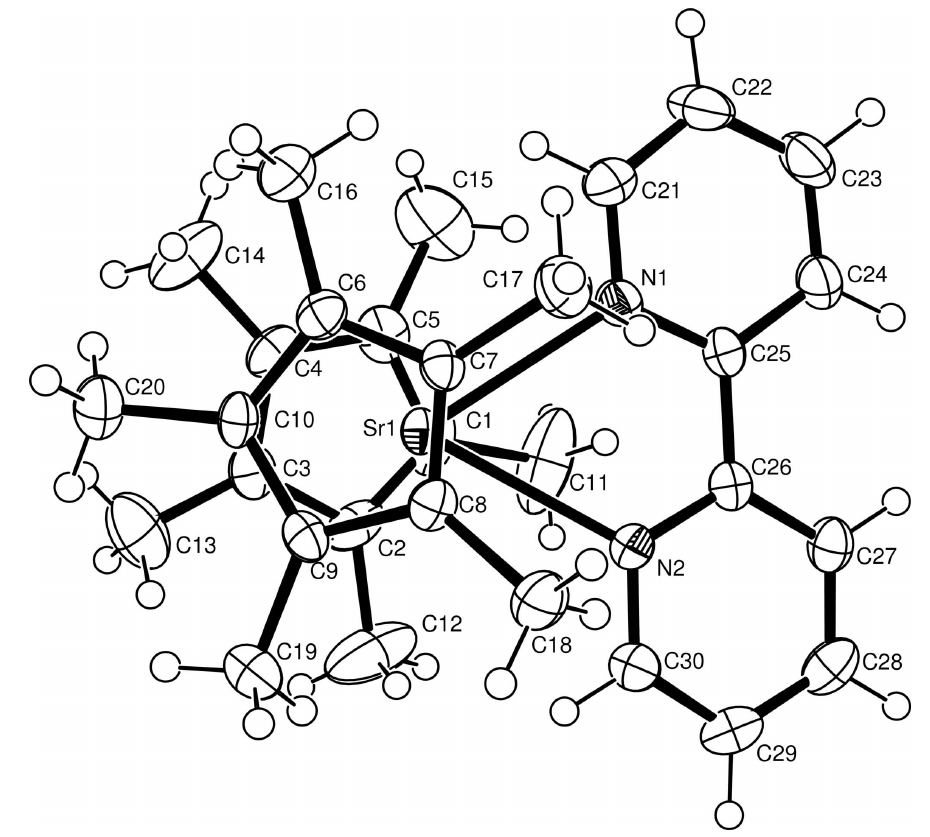
Figure 1 View of the structure of ( η 5 -C drawn at the 50% probability